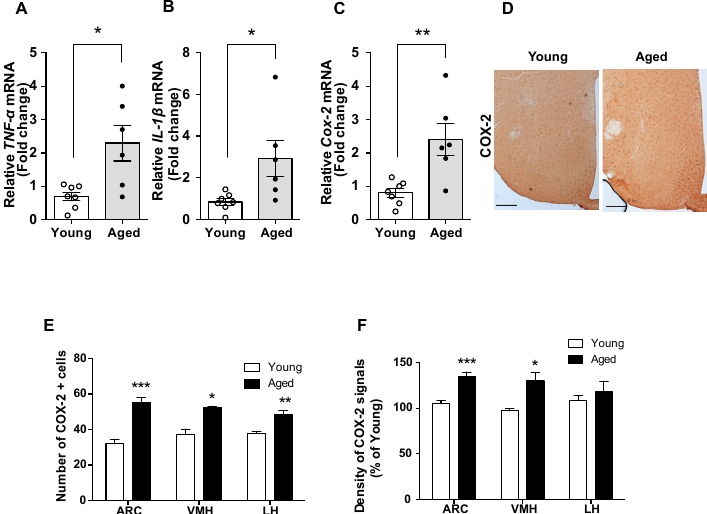
Figure 1. Enhanced hypothalamic inflammation occurred in the aged mice. The comparison between young and aged C57BL/6 mice revealed that the mRNA levels of genes involved in inflammation, such as ( A ) TNF- α , ( B ) IL-1 β , and ( C ) COX-2 , are increased in hypothalamic samples from aged mice. ( D ) Representative images showing the immunosignals of COX-2 in the hypothalamus of young and aged mice. Quantification of ( E ) the number of COX-2-positive cells and ( F ) the intensity of COX-2 immunoreactive signals in hypothalamic nuclei such as the arcuate nucleus (ARC), ventromedial nucleus of the hypothalamus (VMH), and lateral hypothalamus (LH) reveals that these parameters are higher in aged mice compared with young mice. The results are presented as the means ± SEMs. n = 6–7 for each group. * p < 0.05, ** p < 0.01, *** p < 0.001 for the aged group versus the young group. Scale bar = 100 µ